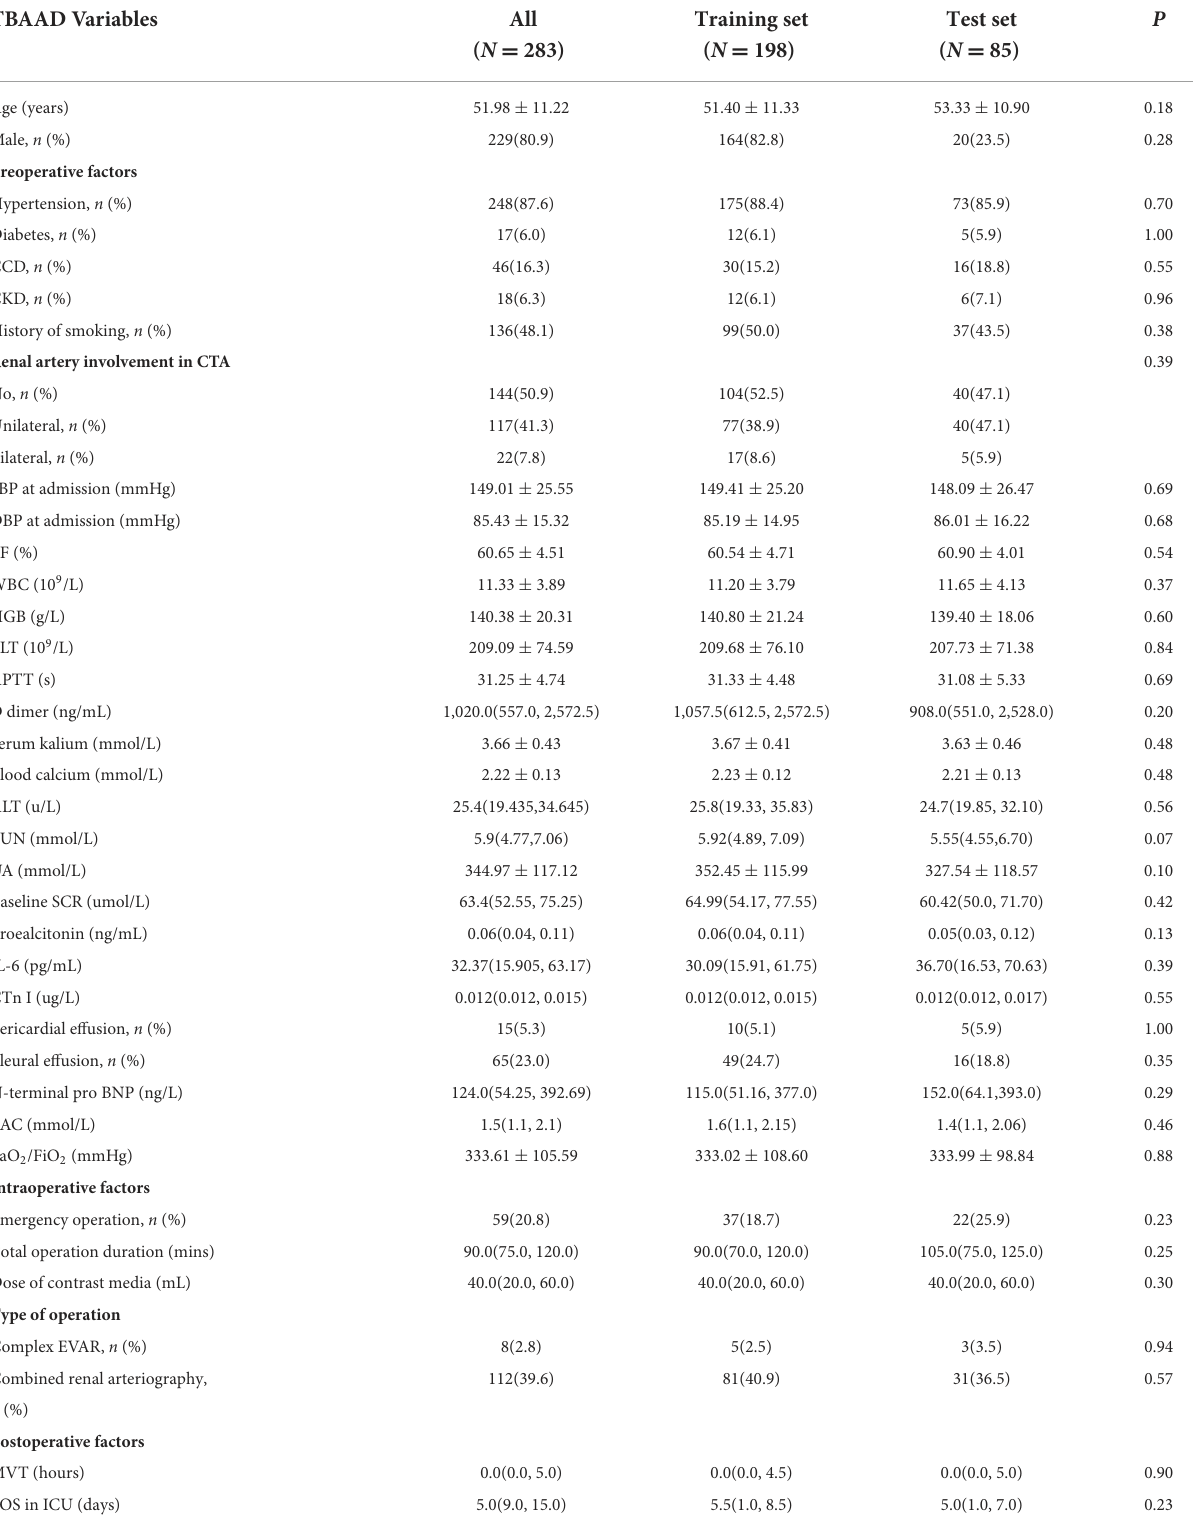
TABLE 2 TBAAD patient characteristics and perioperative